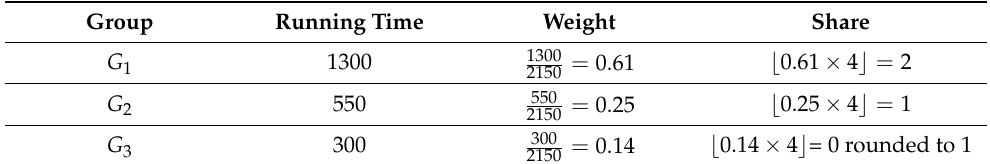
Table 2. Resource allocation (share